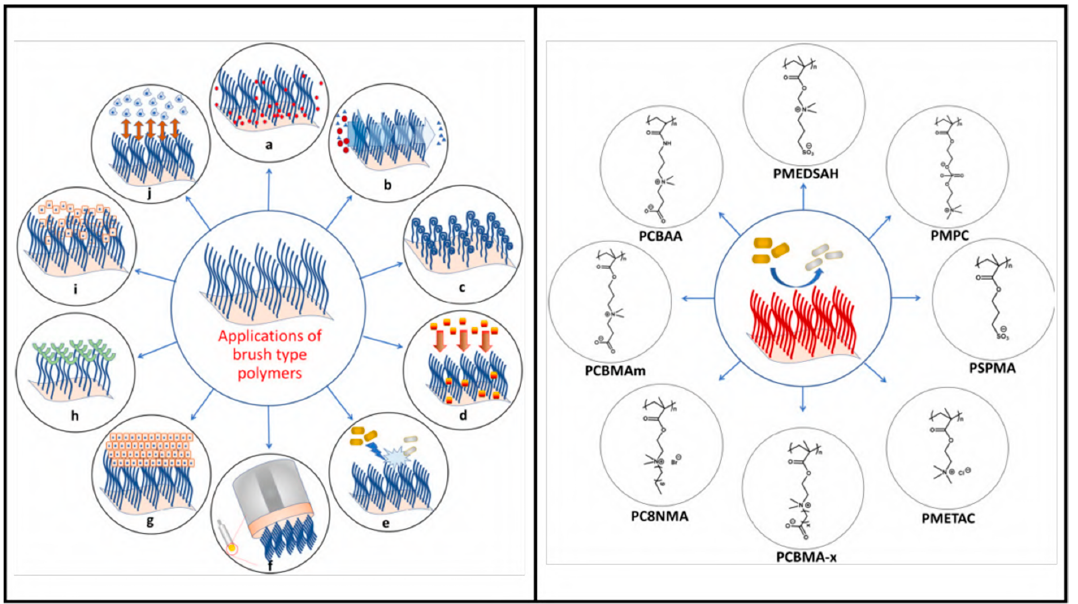
Figure 13. Applications of brush ‐ type polymer coatings (a; drug delivery systems, b; membrane applications, c; smart membrane and surface applications, d; biosorption, e; antibacterial surfaces, f; biosensor applications, g; cell adhesive surfaces, h; biocompatible coatings, i; tissue engineering applications, and j; antifouling surfaces) ( Left ). Brush ‐ type polymer structures are commonly used to prevent microbes from adhering to surfaces ( Right ) (reprinted with permission from Açar ı et al., 2022 [146]).